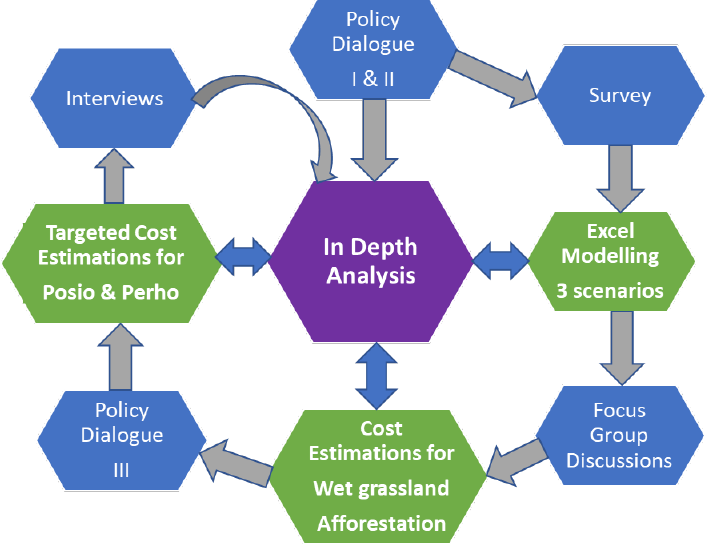
Fig. 1. Feedback loops in a deliberate and innovative way between the qualitative and quantitative methods for data evaluation, validation, and reflection